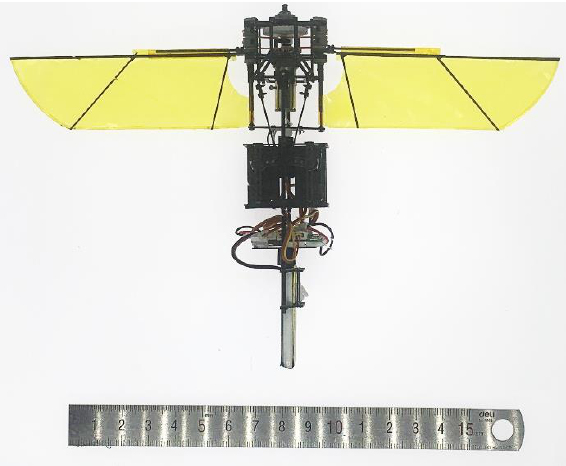
Table 2. The main properties of the FMAV prototype.